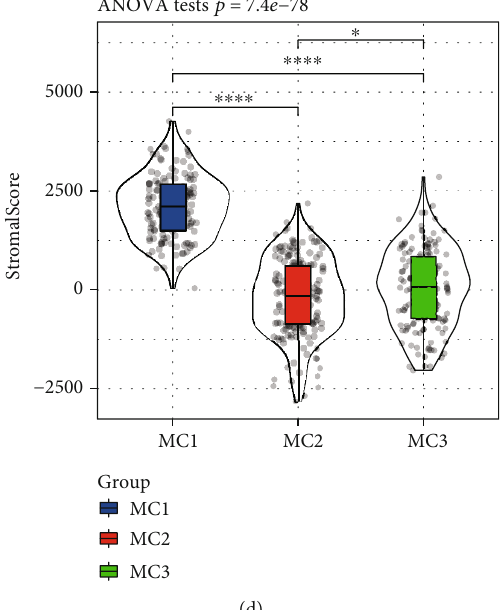
Figure 5: (a) Comparison of the subtypes of 28 immune cell scores evaluated by ssGSEA. (b) Comparison of the subtypes of 10 immune cell scores evaluated by MCP-Counter. (c) Comparison of the subtypes evaluated by the ESTIMATE of StromalScore score. (d) Comparison of the subtypes by the ESTIMATE score evaluated by ssGSEA Subtype comparison. ANOVA test was conducted among three groups. ns: no signi fi cance. ∗ P < 0 : 05 , ∗∗ P < 0 : 01 , ∗∗∗ P < 0 : 001 , and ∗∗∗∗ P < 0 : 0001